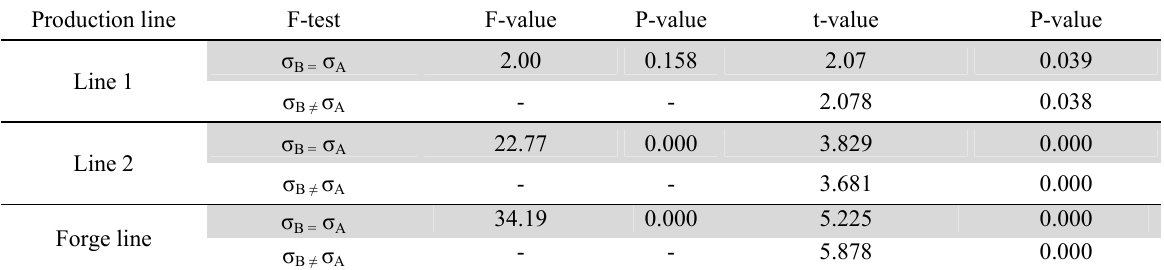
Production line